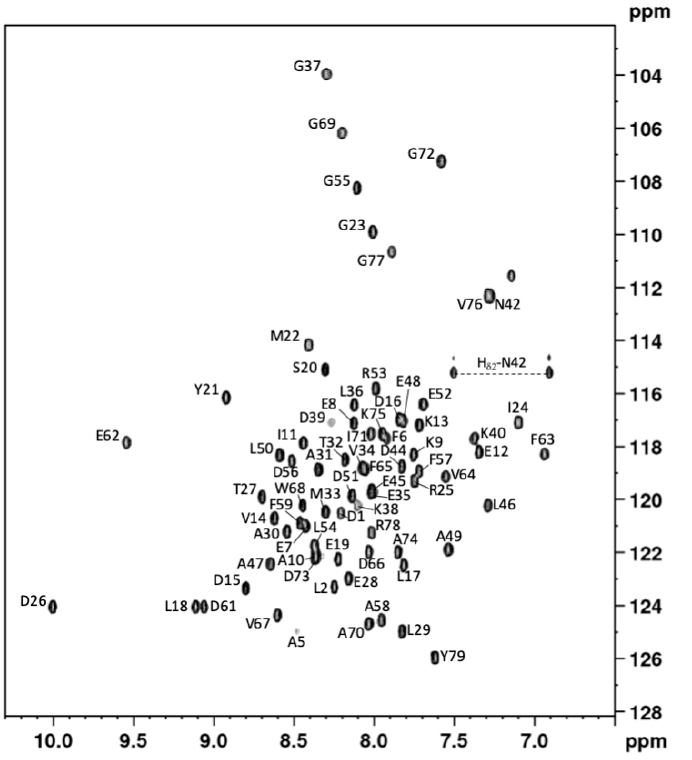
Figure 1. GIPC1-GH2 NMR fingerprint. [ 1 H- 15 N] HSQC spectrum of GIPC1-GH2 at 800 MHz, 20 °C on a 0.5 mM, 15 N uniformly labeled sample dissolved in a 20 mM Tris-HCl pH 7.2, 150 mM NaCl buffer. Cross-peak assignments are indicated using the one-letter amino acid and number code.